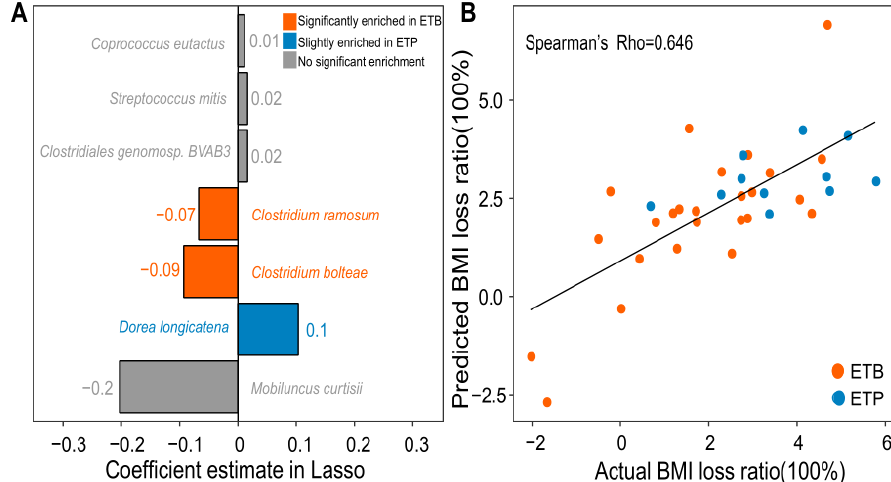
Figure 5. Prediction of BMI loss ratio using baseline abundances of gut microbial species. ( A ) Bar plot showing the 7 gut microbial species selected by least absolute shrinkage and selection operator (Lasso). Bar length indicates a regression coefficient of each species estimated by Lasso. Orange, species significantly enriched in ETB subjects (BH-adjusted P < 0.05); blue, species slightly enriched in ETP subjects ( P < 0.05 and BH-adjusted P = 0.06); grey, species with no significant enrichment between two enterotypes ( P > 0.05). ( B ) Scatter plot showing prediction performance of BMI loss ratio based on the 7 selected species. Leave-one-out cross-validation (LOOCV) was applied to evaluate the performance of the generalized linear model (GLM), showing a strong Spearman’s rho between actual BMI loss ratios and predicted BMI loss ratios of 0.646. Red circles—ETB individuals; blue circles—ETP